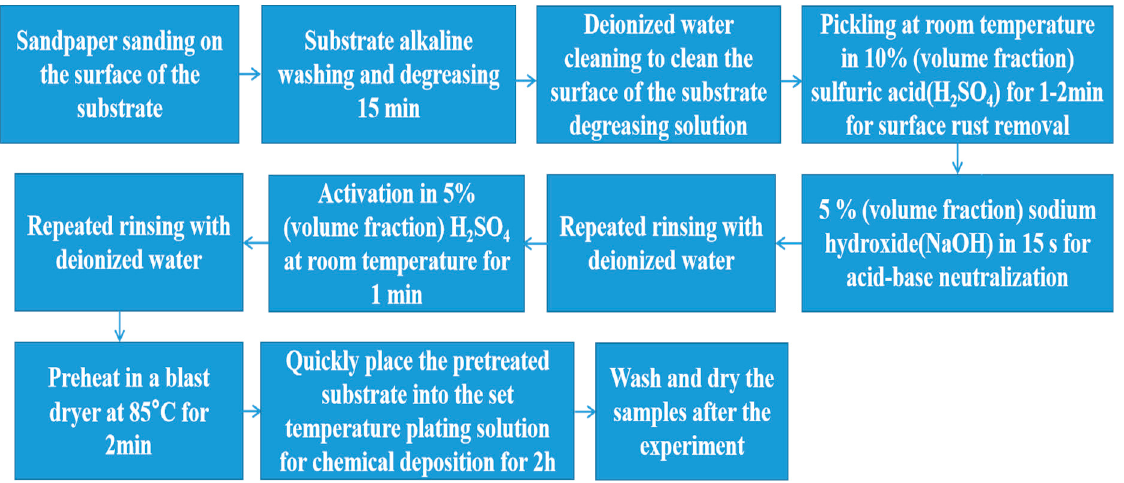
Figure 1. Flow chart of experimental process setup. Table 1. Composition and technological conditions of Ni-Cu-P-PTFE plating solution.